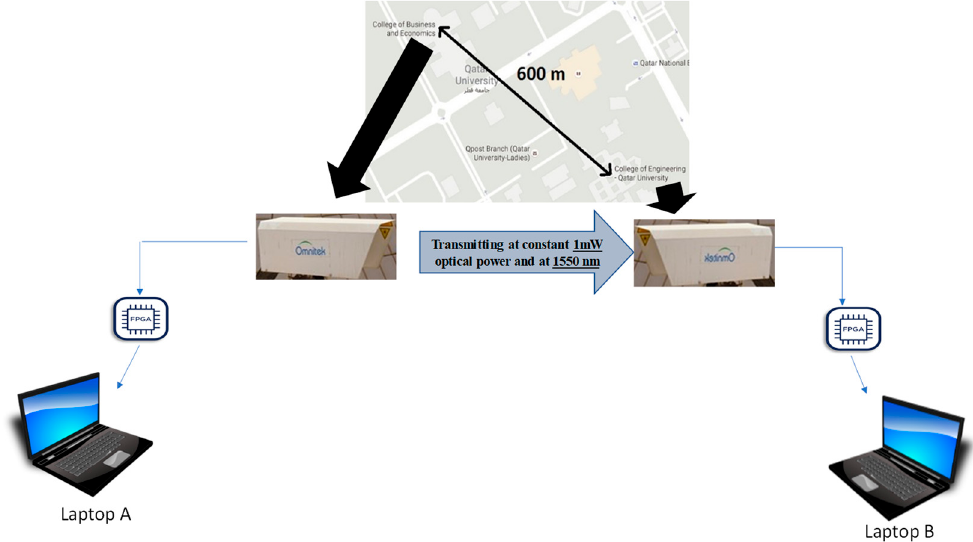
Figure 1. Details of the free-space optical (FSO) system installed at Qatar University.